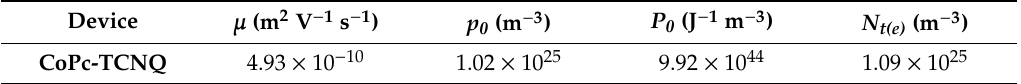
Table 2. Electrical properties for glass / ITO / MM / Ag